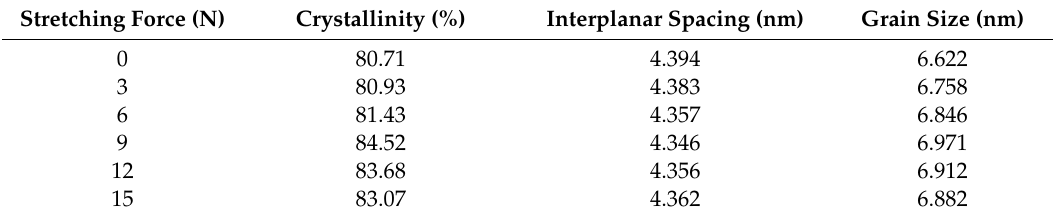
Figure 6. XRD spectra of the aramid fiber under di ff erent tensile conditions in pure scCO 2 under stretching forces of 0, 3, 6, 9, 12 and 15 N, with the same conditions of sample 2 in Table 1. Table 4. Crystallinity characteristics of the fibers treated under tension in pure scCO 2